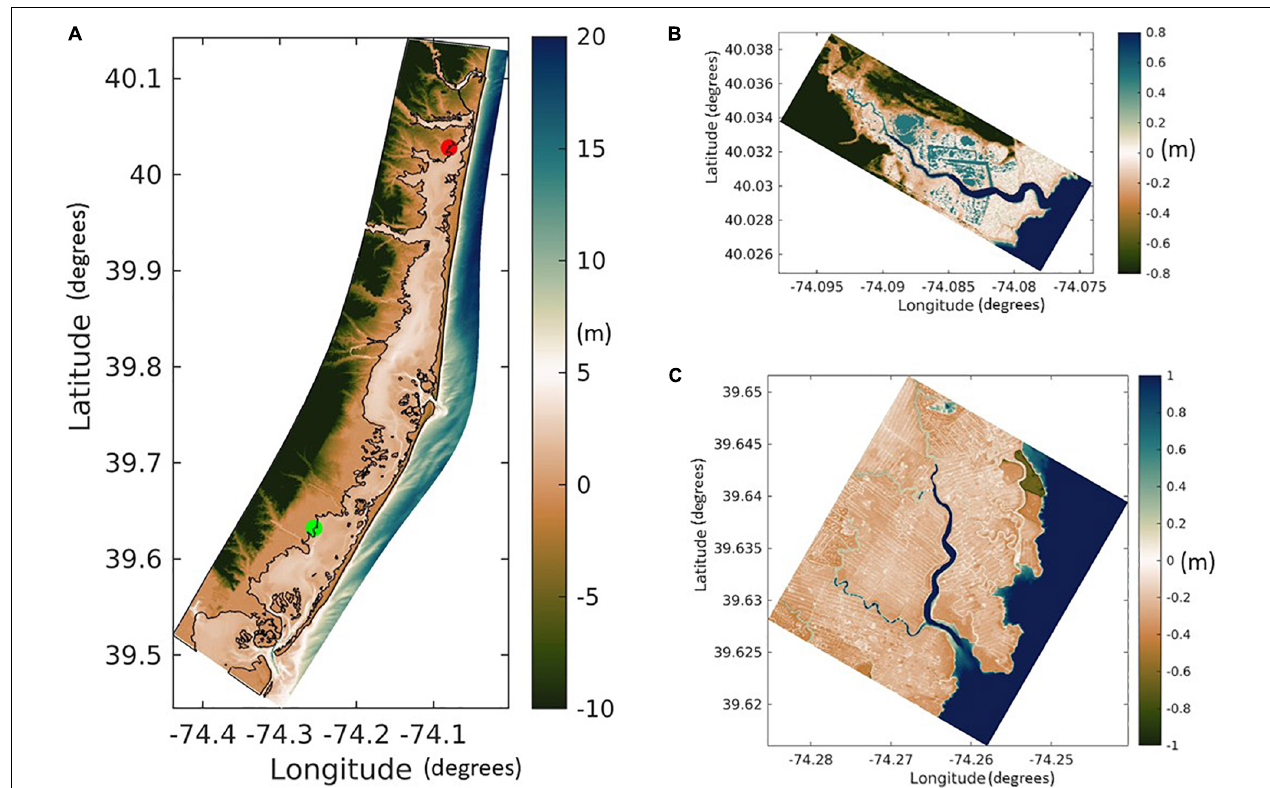
FIGURE 3 | Colormaps of bathymetry with negative values representing elevation above MSL and positive values representing depth below MSL from (A) Barnegat Bay grid from Defne et al. (2019) with red and green circles showing the location of Reedy and Dinner Creek observations, respectively (Ganju et al., 2017), (B) Reedy Creek, and (C) Dinner Creek